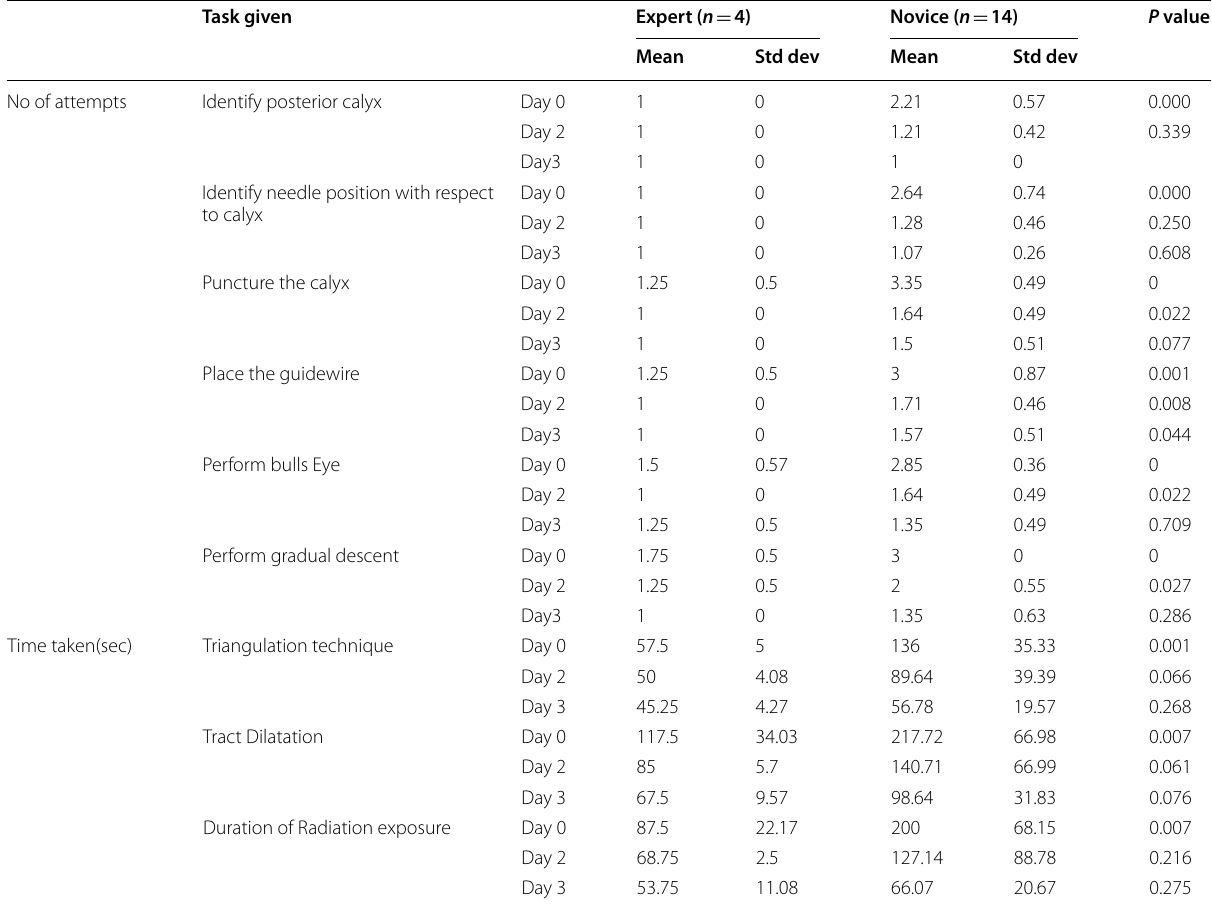
Table 1 Comparison of mean number of attempts and time taken for various tasks performed by expert and novice on day 0, 2 and 3 Task given